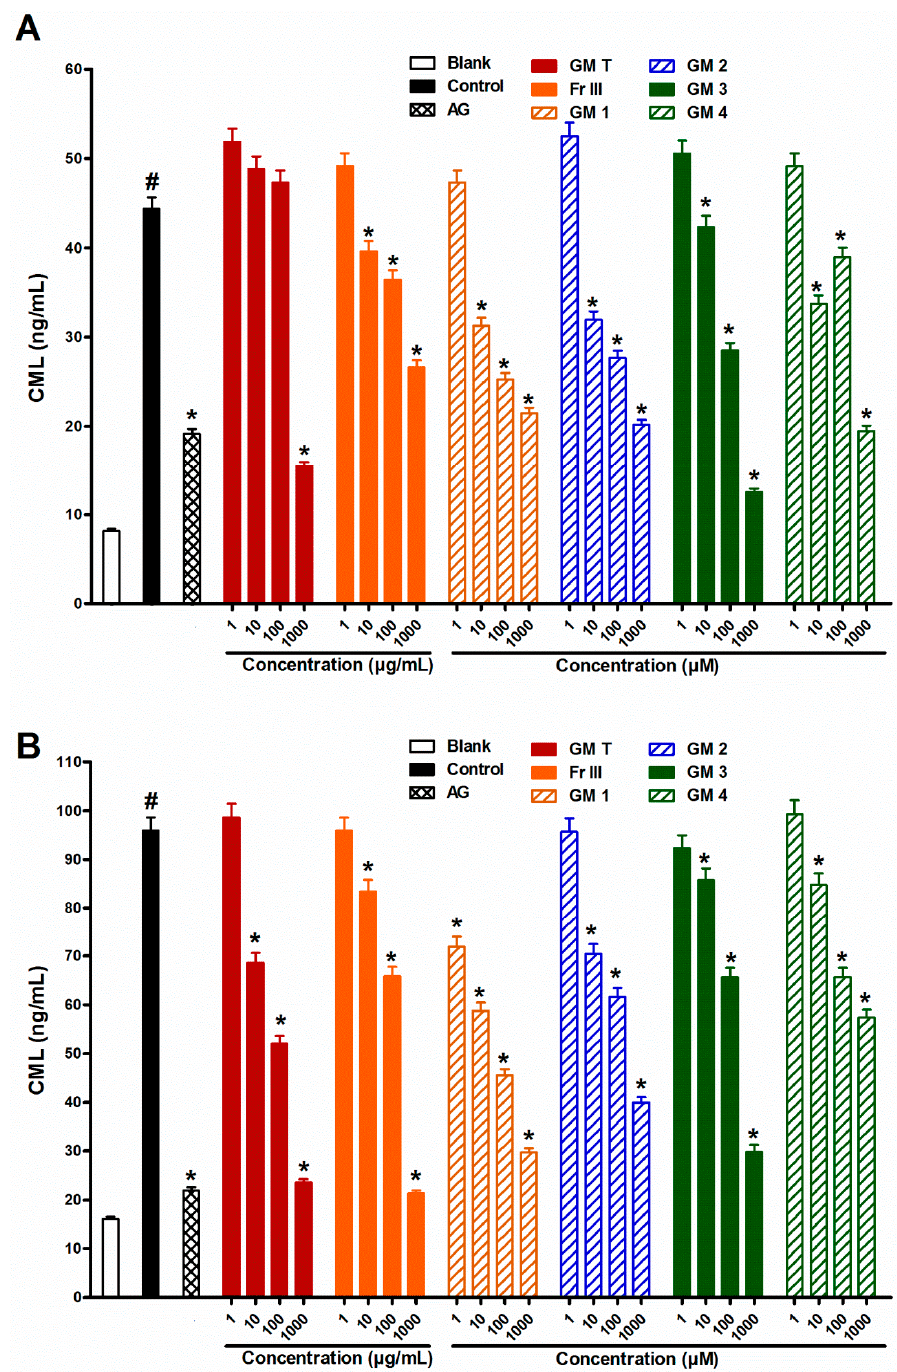
Figure 2. Effect of GMT, Fr III and isolated compounds on non-fluorescence AGEs level ( N ε -CML) when BSA incubated with glucose ( A ), and ribose ( B ) at week 4. Blank is a reaction mixture including BSA and glucose or ribose kept at − 20 °C while control is the same reaction mixture but incubated at 37 °C. AG was used as standard anti AGEs drug. Results are expressed as mean ± SEM ( n = 3). # p < 0.05 when compared to Blank, * p < 0.05 when compared to Control.